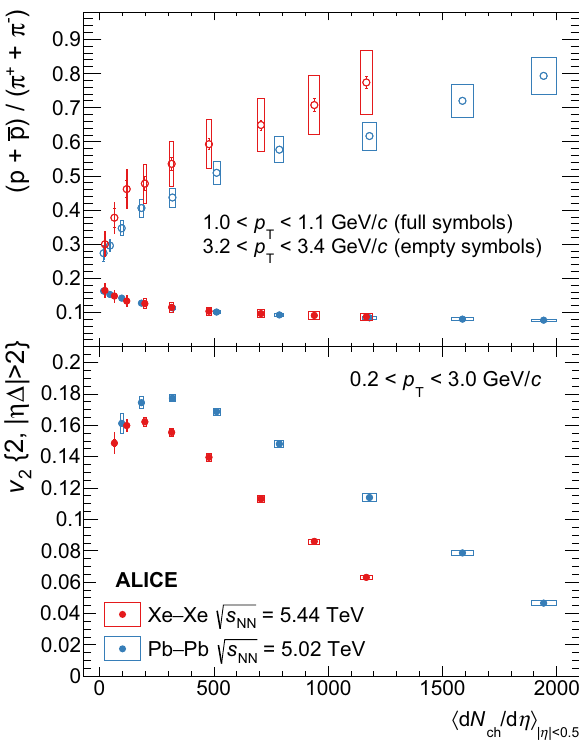
Fig. 6 Ratio of kaon, proton and φ integrated yields to pion inte- grated yield as a function of the charged-particle multiplicity density √ s NN = 5 . 44 TeV and Pb–Pb collisions at √ for Xe–Xe collisions at s NN = 2 . 76 TeV [2,48] and 5.02 TeV [11,26]. The statistical and systematic uncertainties are shown as error bars and boxes around the data points. Predictions from the canonical statistical model (CSM) are shown as bands considering different correlation volumes [59] (based on [22]) and chemical freeze-out temperatures [56]. The correlation volume indicates the volume over which the strangeness conservation is